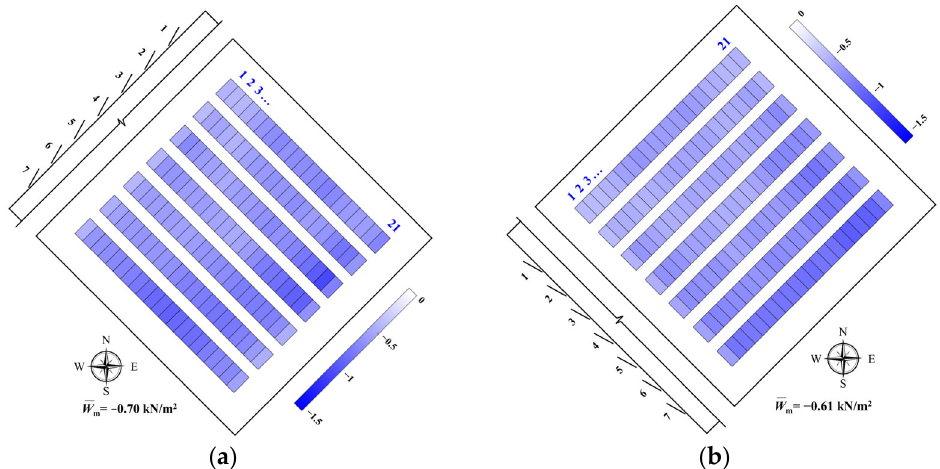
Figure 10. Distributions of extreme wind loading W m of solar arrays installed in Jinan, China, with different building orientations: ( a ) α = 45°; ( b ) α = − 45°.